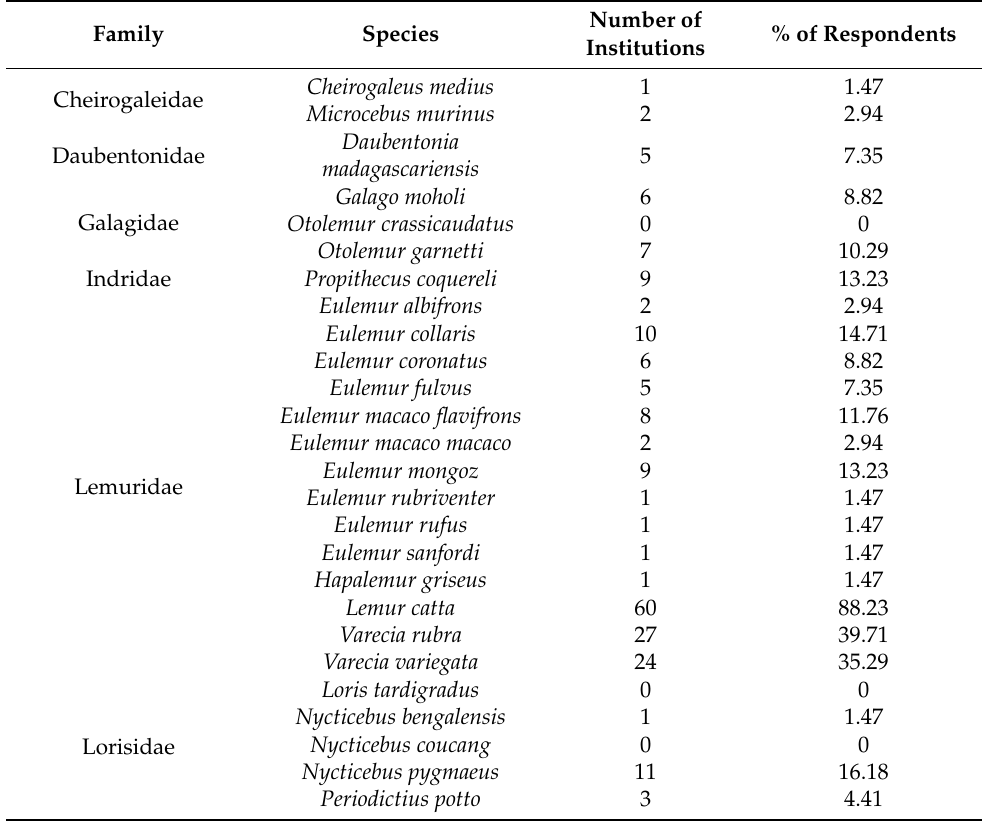
Table 2. Strepsirrhine species trained in North American institutions ( n = 68). Family Species